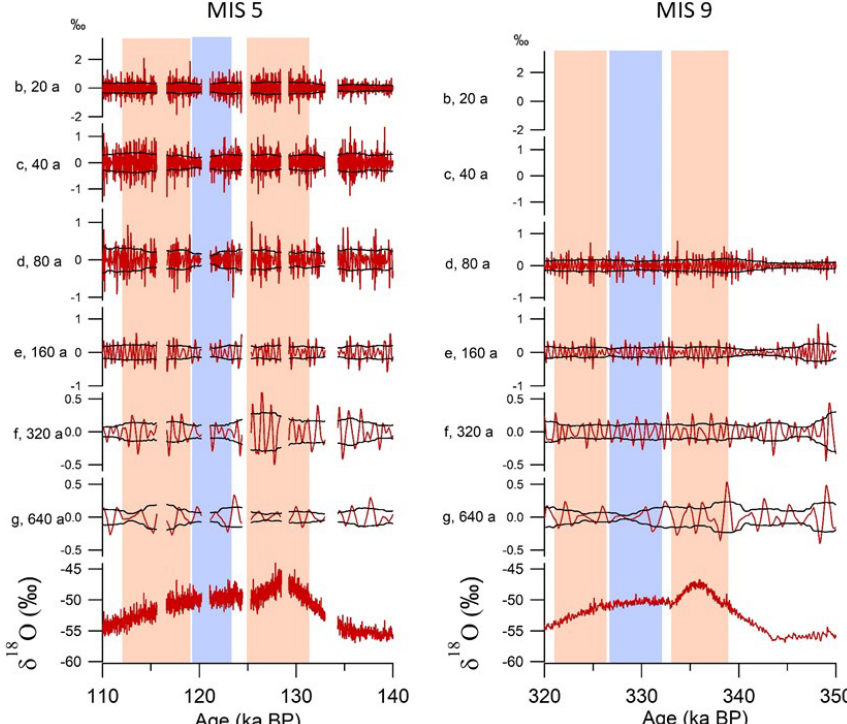
Figure 6. Contributions to the original δ 18 O signal (red) of the MRA composites with resolutions of 20 (b) , 40 (c) , 80 (d) , 160 (e) , 320 (f) and 640 (g) years for MIS 5 (left panel) and MIS 9 (right panel). The black envelope presents the running standard deviation (1 σ ) in 3kyr windows. The red rectangles indicate periods with enhanced variability and the blue rectangles indicate periods with reduced